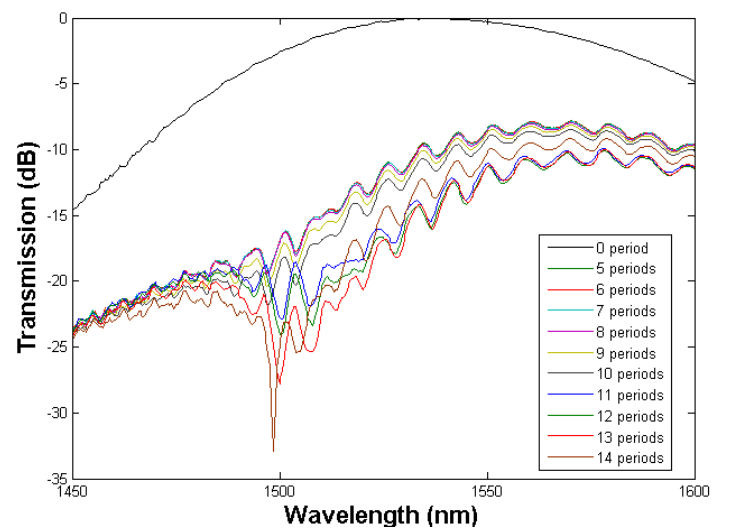
Figure 4. The transmission spectrum of an LPG in the RHOF with Λ = 450 µm.